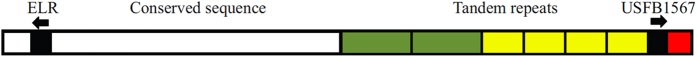
Schematic illustration of the non-coding regions of the mitochondrial minichromosomes of the elephant louse, Haematomyzus elephantis.USFB1567 and ELR are the primers used to amplify the coding regions of all mitochondrial minichromosomes. A 346-bp unit (in green) repeated twice and a 225-bp unit (in yellow) repeated 4 times; the sequence similarity between/among the repeat copies of each unit is ~85%. A 99-bp sequence (in red) is present only in T-nad1-Q minichromosome.